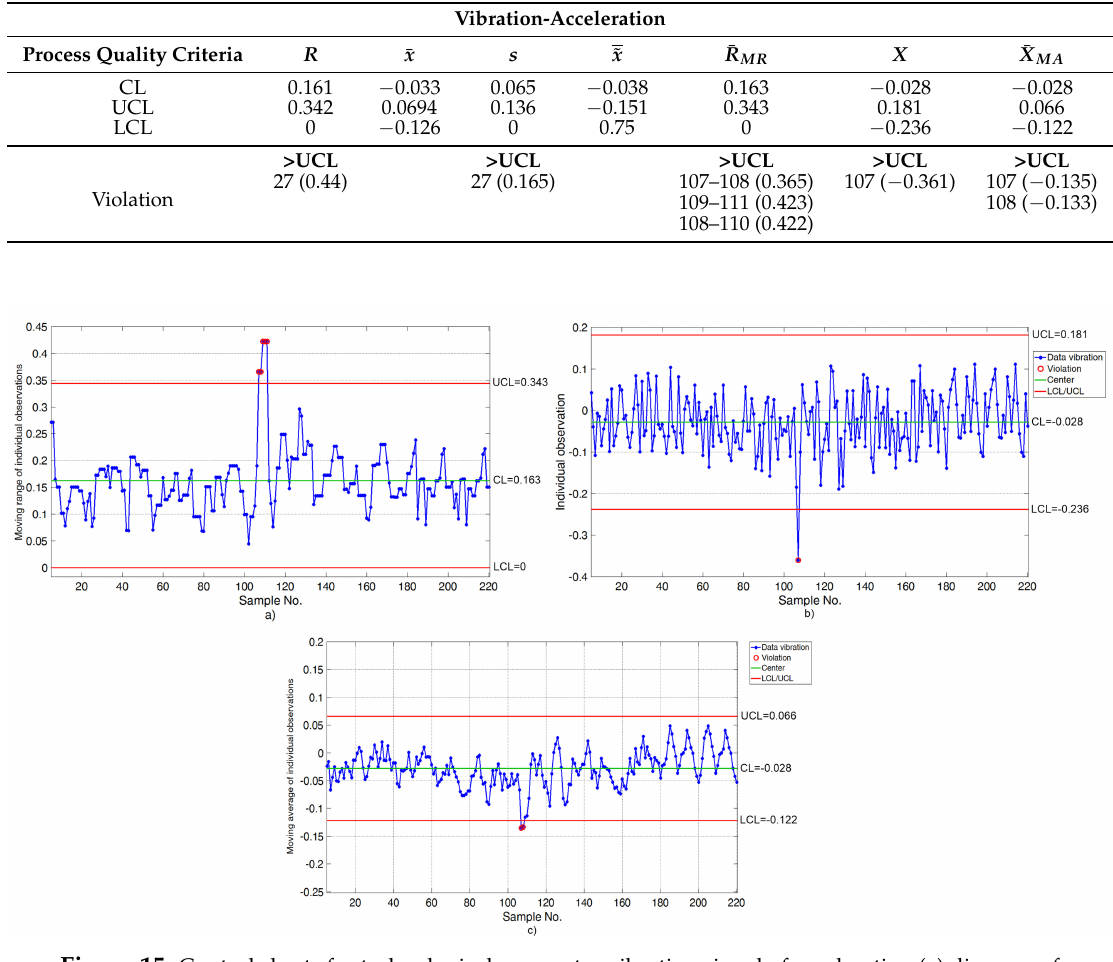
Figure 15. Control charts for technological parameter vibration signal of acceleration ( a ) diagram of moving range, ( b ) diagram of individual values, ( c ) diagram of moving